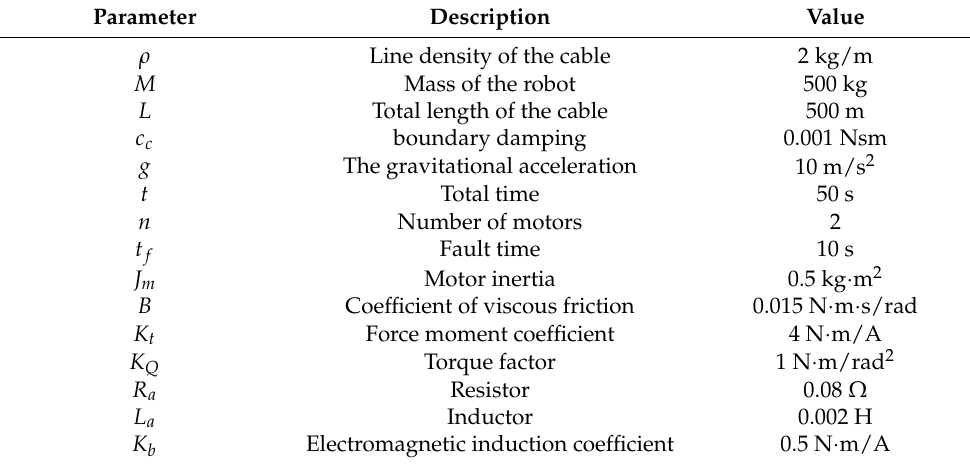
Table 2. The parameters of the systems in the numerical analysis.